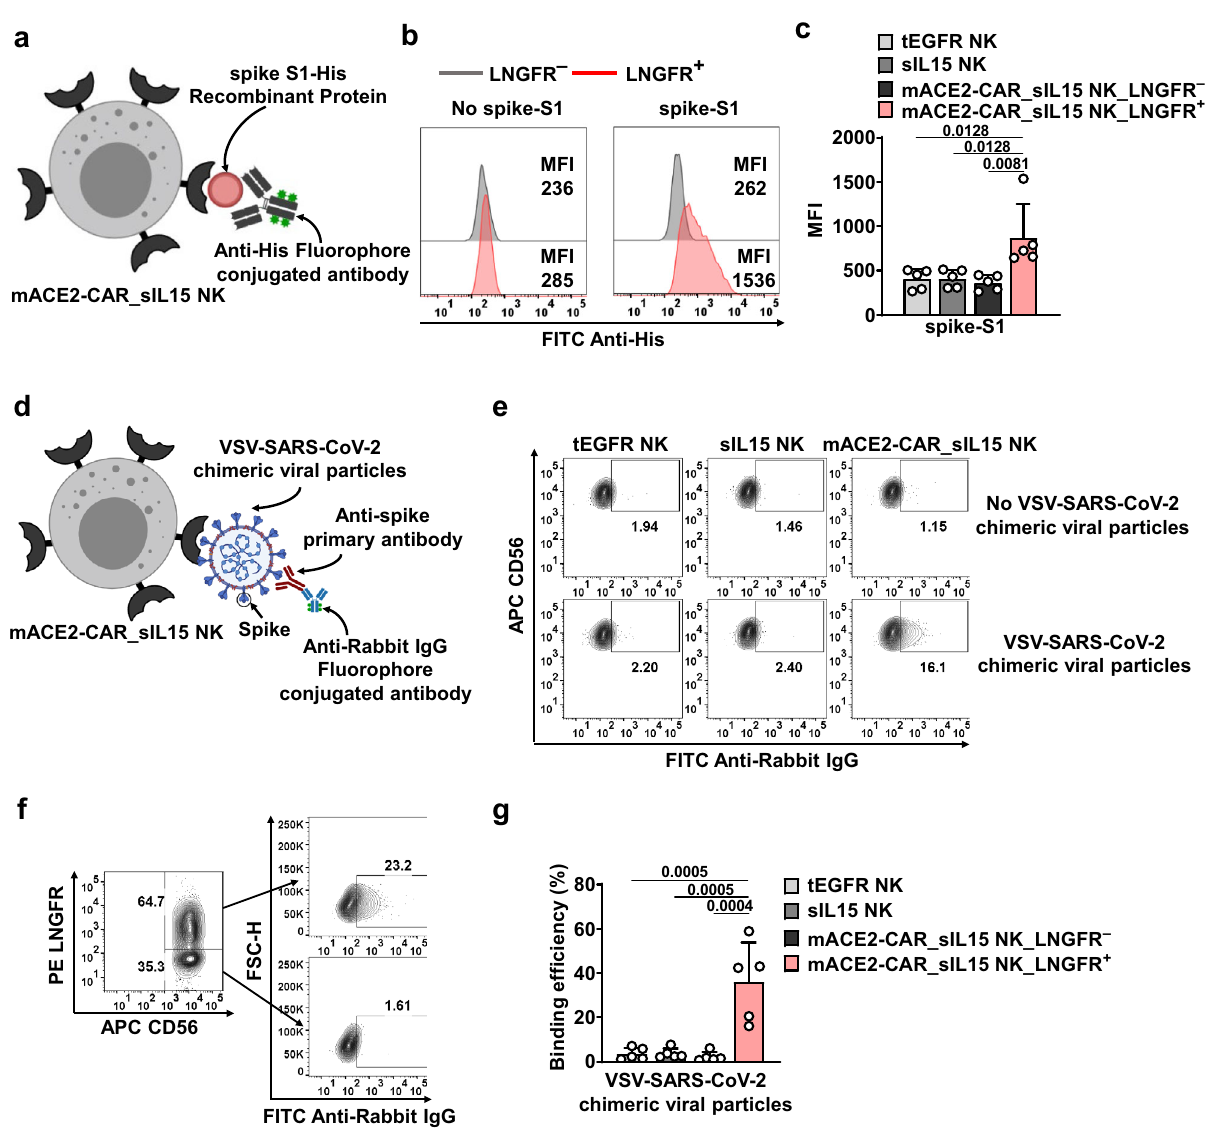
Fig. 2 mACE2-CAR_sIL15 NK cells bind to SARS-CoV-2 spike protein and VSV-SARS-CoV-2 chimeric viral particles. a Diagram of mACE2-CAR_sIL15 NK cells binding to spike S1-His-tagged recombinant protein. MFI = mean fl uorescence intensity. The picture was created with BioRender.com. b , c Representative fl ow cytometry plots showing the results of mACE2-CAR_sIL15 NK cells binding to spike S1-His-tagged recombinant protein ( b ). LNGFR was used as a marker for mACE2-CAR-positive NK cells. Summary data from fi ve different donors are shown in c . P values were determined by one-way ANOVA with multiple comparisons and adjusted by the Holm – Sidak method. Data are presented as mean ± SD. d Diagram of spike S1-His-tagged recombinant protein binding to VSV-SARS-CoV-2 chimeric viral particles, which are recognized by anti-spike and its corresponding fl uor-conjugated secondary antibody. The picture was created with BioRender.com. e Representative fl ow cytometry plots showing the ef fi ciency of control NK or mACE2- CAR_sIL15 NK cells binding to VSV-SARS-CoV-2 chimeric viral particles. f , g Representative fl ow cytometry plots showing the ef fi ciency of CAR-negative or CAR-positive subsets in mACE2-CAR_sIL15 NK cells binding to VSV-SARS-CoV-2 chimeric viral particles. Summary data from fi ve different donors are shown in g . P values were determined by one-way ANOVA with multiple comparisons and adjusted by the Holm-Sidak method. Data are presented as mean ± SD. Source data are provided as a Source Data fi parameters of NK cell function. Consistent with our cytotoxicity from control tEGFR NK cells. On the other hand, mACE2- results, mACE2-CAR_sIL15 NK cells signi fi cantly increased CAR_sIL15 NK cells produced small amounts of IL-15 (mean CD107a degranulation and the secretion of TNF- α and IFN- γ in 57.2 pg/ml/10 6 cells, range 31.6 – 94.3 pg/ml/10 6 cells) in the absence of A549-spike cells and signi fi cantly more (mean the presence of A549-spike cells compared to tEGFR or sIL15 105.6 pg/ml/10 6 cells, range 54.9 – 135.4 pg/ml/10 6 cells) when control NK cells. However, there was no difference between the cultured with A549-spike cells (Fig. 3e). Collectively, these results mACE2-CAR_sIL15 NK and control NK cells in the presence of indicate that mACE2-CAR_sIL15 NK cells exhibit speci fi c and parental A549 cells (Fig. 3d and Supplementary Fig. 2c). We also robust NK cell effector function in the presence of target cells that measured IL-15 release after culturing mACE2-CAR_sIL15 NK express the SARS-CoV-2 spike protein, mimicking a response to cells and control tEGFR NK cells in the presence or absence of cells infected with SARS-CoV-2. A549-spike cells for 72 h. IL-15 was undetectable in supernatants